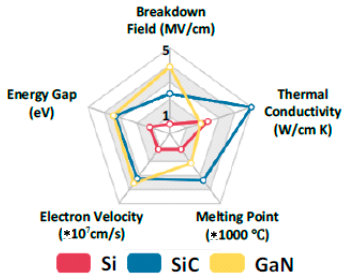
Figure 1. Summary of Si, SiC, and GaN relevant material properties [7].